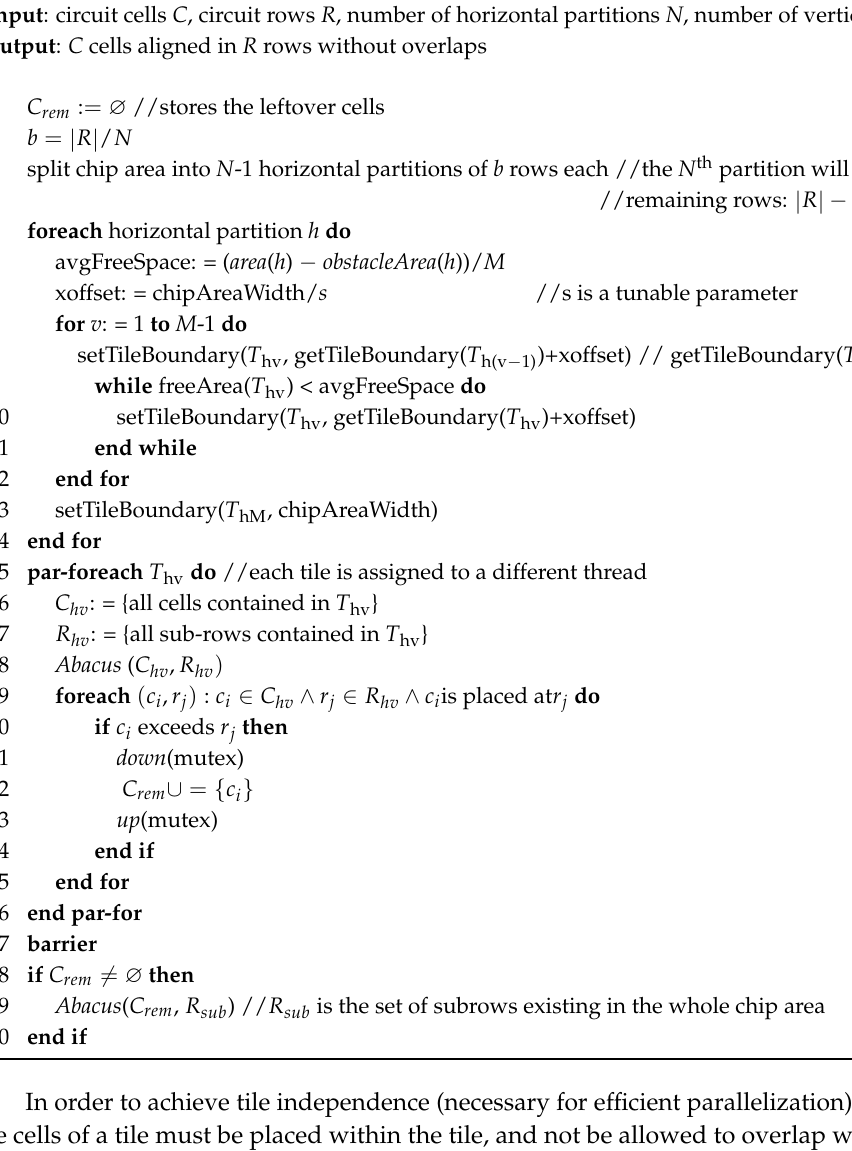
Pseudocode 3: poAbacus